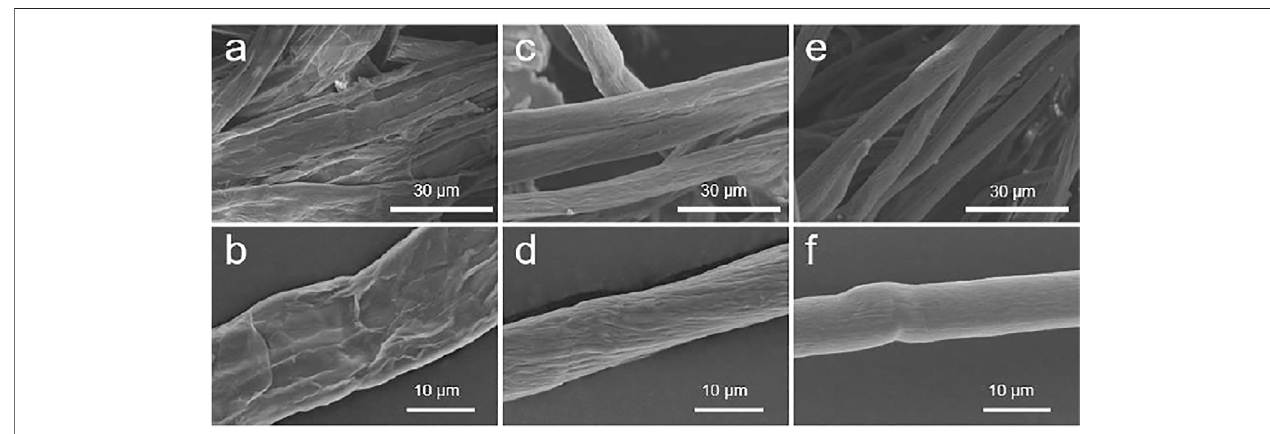
FIGURE 5 | SEM of bagasse fi ber with different treatments (bleached bagasse pulp; AT; FT/AT.).